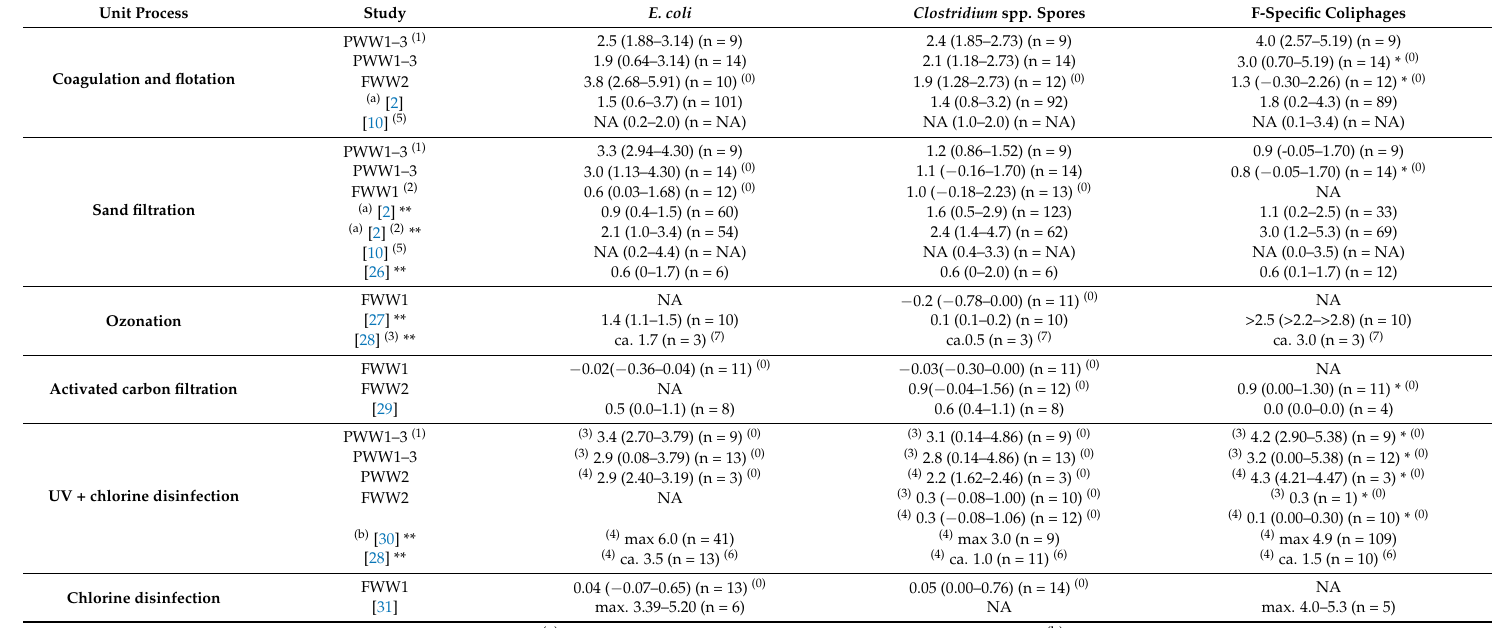
Table 3. Mean and range log 10 removals of the unit processes in PWW and FWW waterworks. Log 10 removals are estimates if calculation includes results below the detection limit. For more detailed results of PWW and FWW see Tables S3 and S4. Also data from the literature is added into table. n = number of